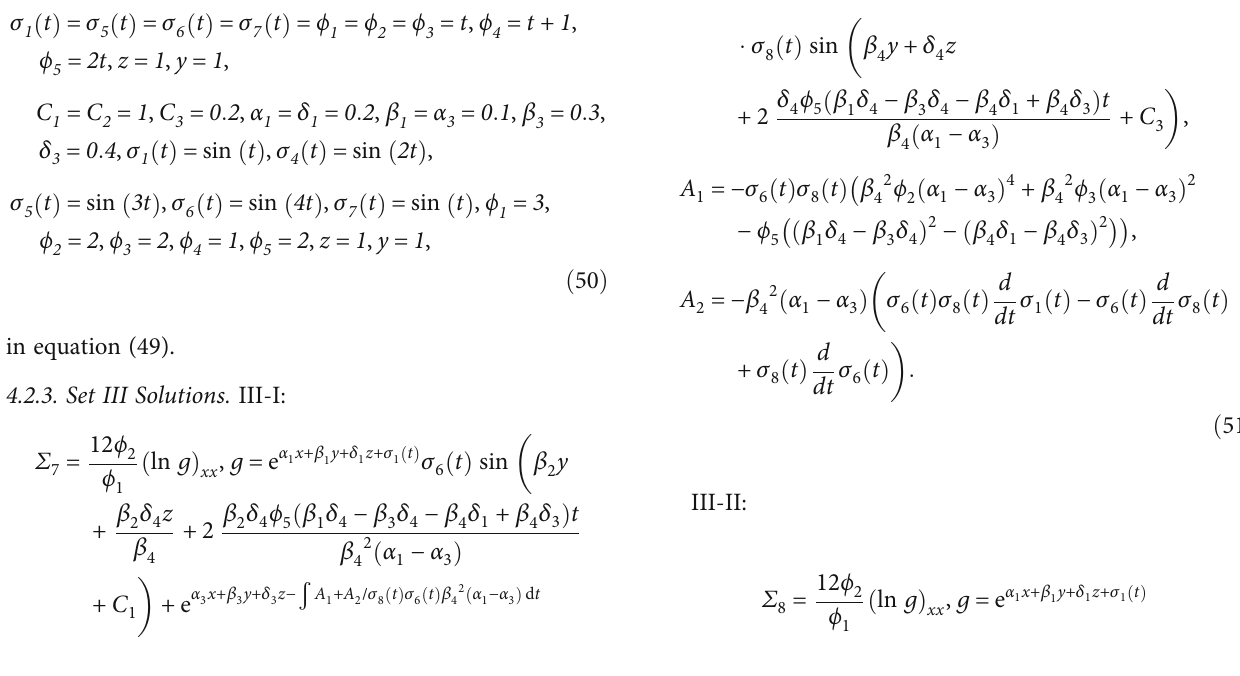
Þ (3D plot, density plot, and 2D plot t ), 6